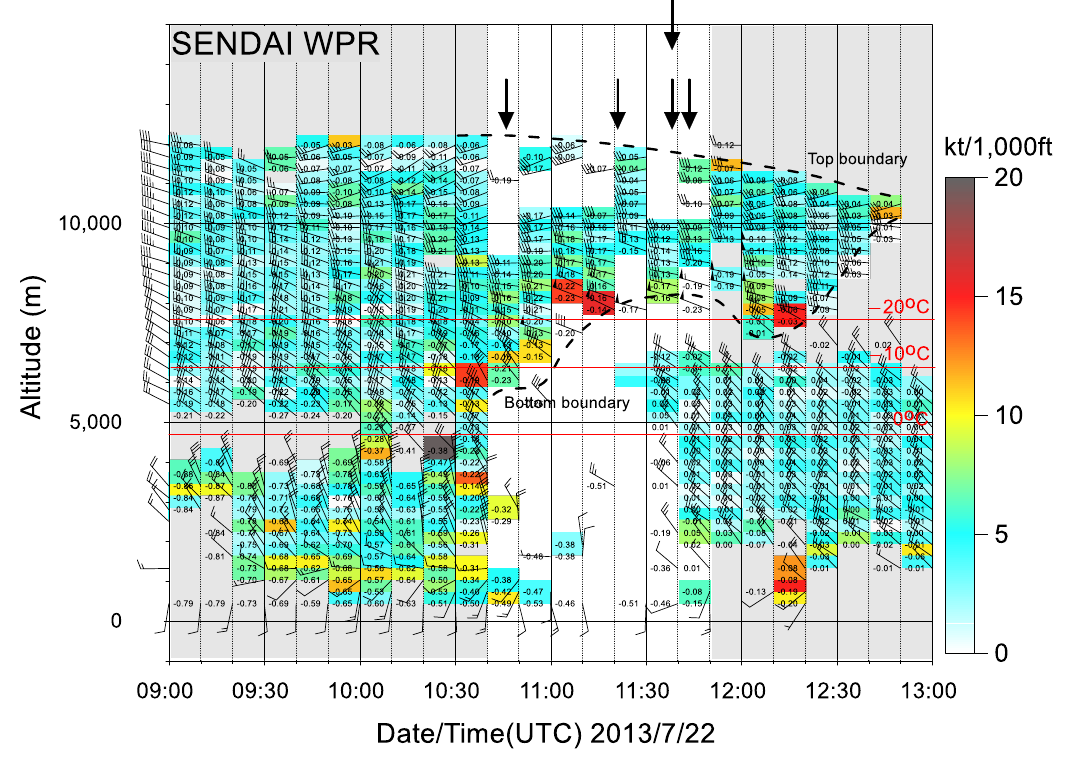
Figure 9. Time sequence of the upper wind profile of 10 min averaged horizontal wind speed, vertical velocity, and vertical wind shear measured by a wind profiler at Sendai, Miyagi. Horizontal wind speed and direction are indicated by wind barb in knots every 10 min on average. The number in the colored square shows the vertical speed of the precipitation particles (m/s). The colored squares indicate vertical wind shear (kt/1000 ft) between two adjacent altitudes (the altitude difference is approximately 300 m) of the wind speed observed (m/s). Arrows depicted in the upper part are the event times of the sprites. Dashed lines roughly trace the upper and bottom boundaries of the stratiform region observed by the wind profiler. The period in white shows the sprite occurrence period.